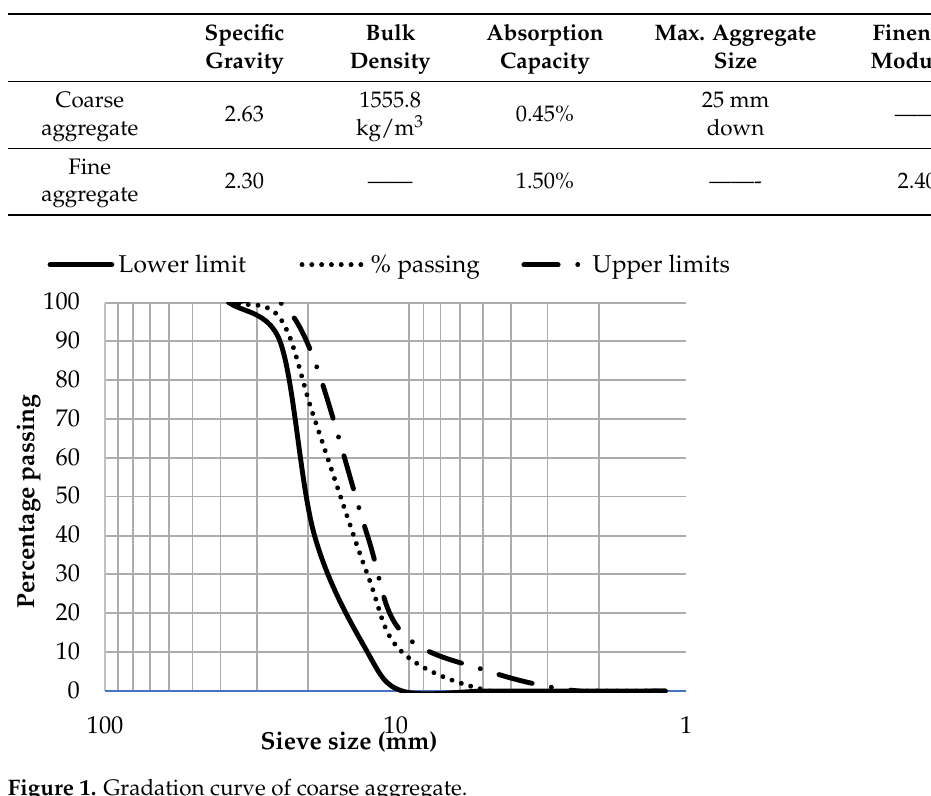
Figure 1. Gradation curve of coarse aggregate. Table 2. Properties of aggregate.